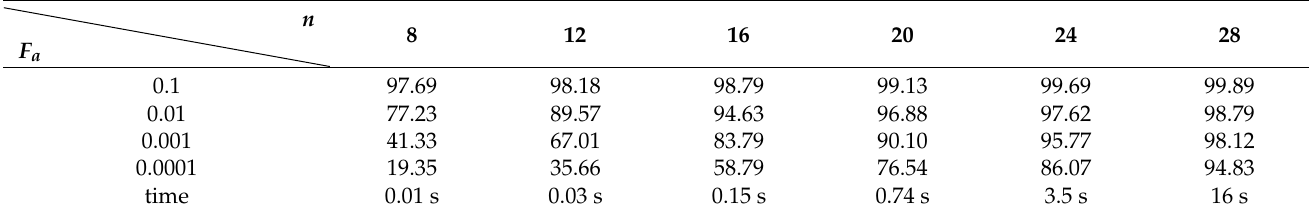
Table 4. 𝑃(𝐵|𝐴) when SCR is 1.5.